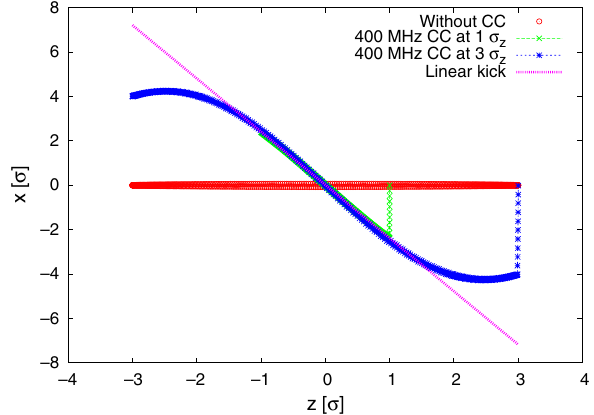
FIG. 2. Effect of the CCs turn by turn on the X orbit of a particle at different longitudinal positions from the center of the bunch at IP5 during 600 LHC turns (about 1 synchrotron period). These CC effects are compared with the ideal linear kick.